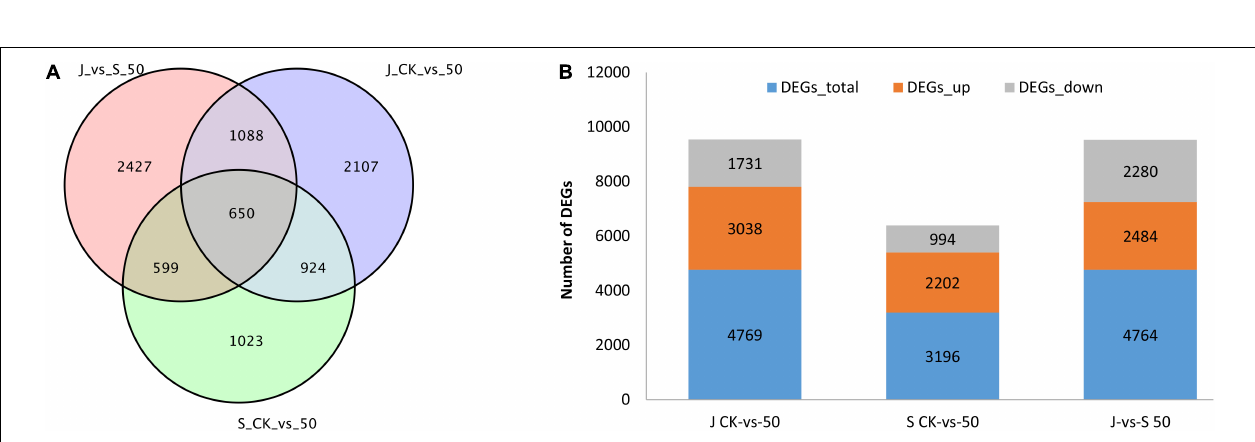
Frontiers in Plant Science |